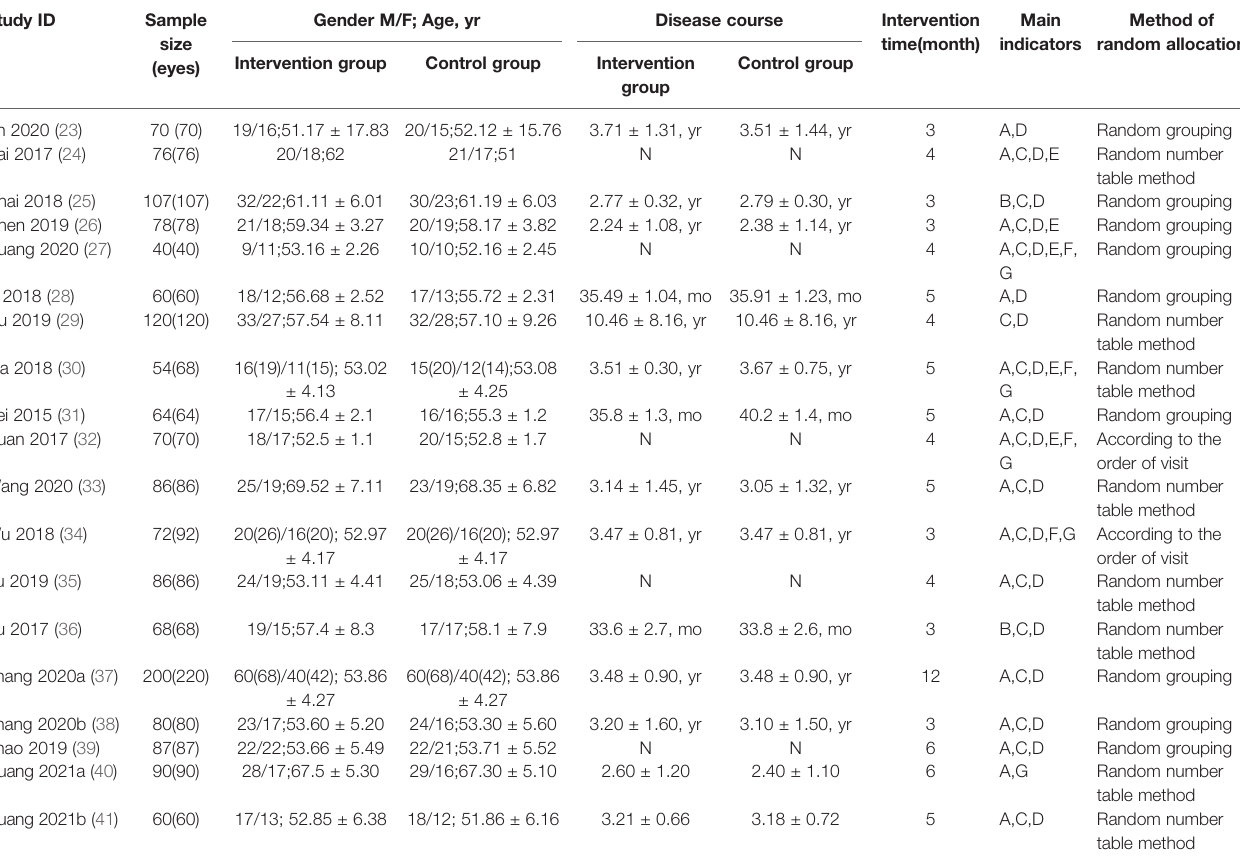
TABLE 1 | Basic characteristics of included studies.